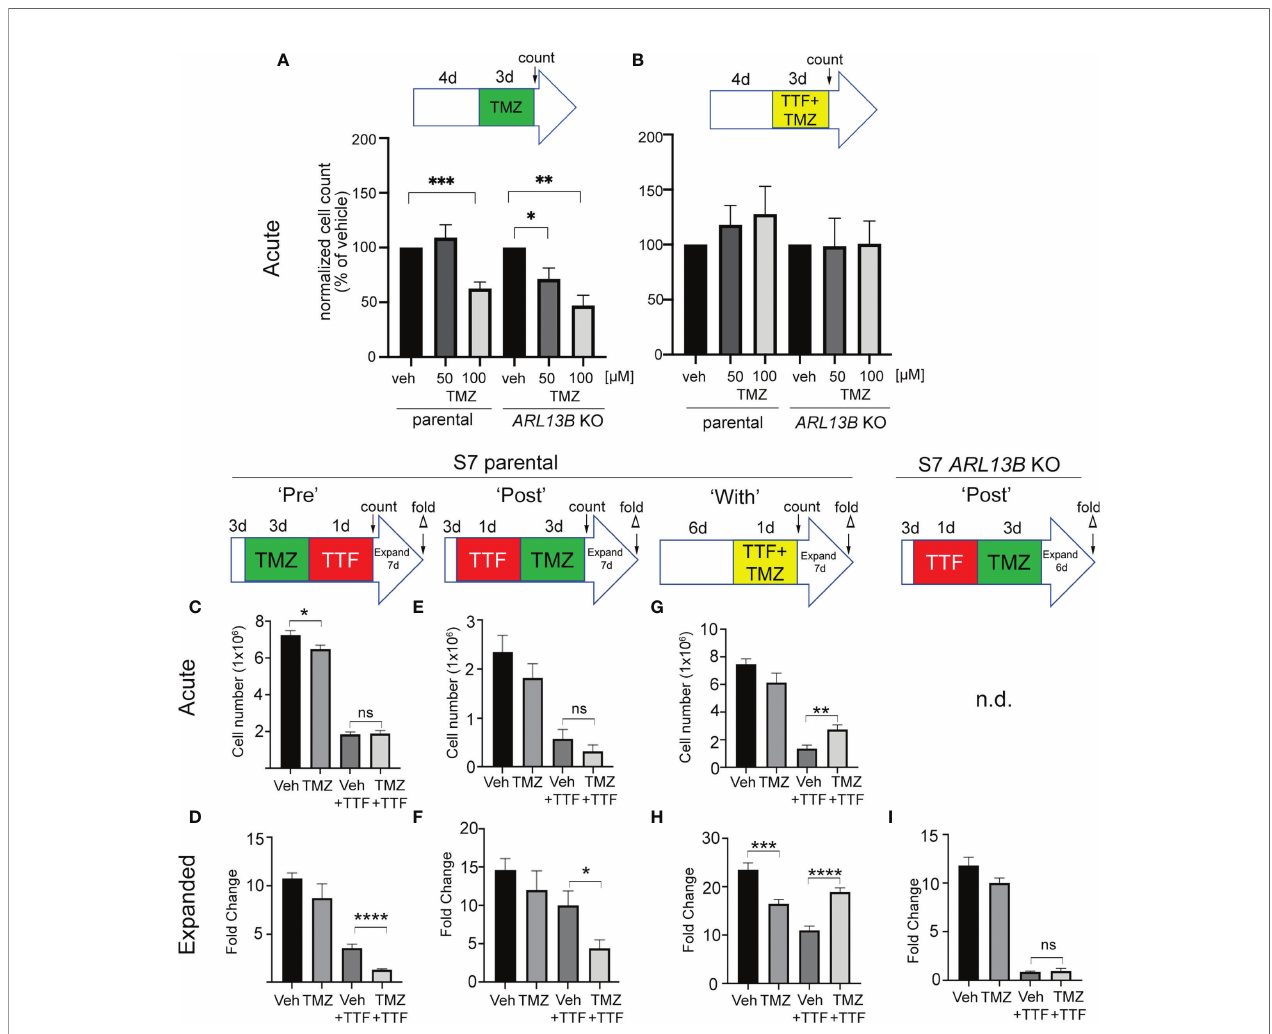
FIGURE 7 | Combined TMZ and TTFields ef fi cacy correlates with treatment sequence and ARL13B + cilia. (A, B) S7 parental or ARL13B KO (clone G12) cells were grown as spheres for 4 days and then treated with vehicle (veh) or 50 or 100 µM TMZ and exposed to an additional 3 days without (A) or with TTFields. Bar graphs show the normalized cell number (% of control) at the end of 7 days. (C, D) TMZ “ pre ” -experiment: S7 parental cells were treated with 100 µM TMZ for 3 days before a 24-h treatment of TTFields or control (con). Cells were counted immediately after this treatment (acute count), and then pooled, and 2.5 × 10 4 cells/well were expanded in fresh media for 7 days in 24-well plates ( n = 12 wells/group), and the fold expansion was calculated (fold count) (D) . (E, F) TMZ “ post ” - experiment: TMZ (100 µM) was given for 3 days after a 24-h TTFields treatment with S7 cells being counted acutely (E) or expanded in fresh media for 7 days (F) . (G, H) TMZ “ with ” experiment: S7 cells were grown for 6 days and then simultaneously treated with TMZ (100 µM) and TTFields for 24 h, counted acutely (G) or examined for fold expansion after 7 days (H) . (I) Similar experiment as (F) but examining fold expansion of S7 ARL13B KO cells after 6 days. n.d., not determined; ns, not signi fi cant; * p < 0.05; ** p < 0.01; *** p < 0.001; **** p < 0.0001